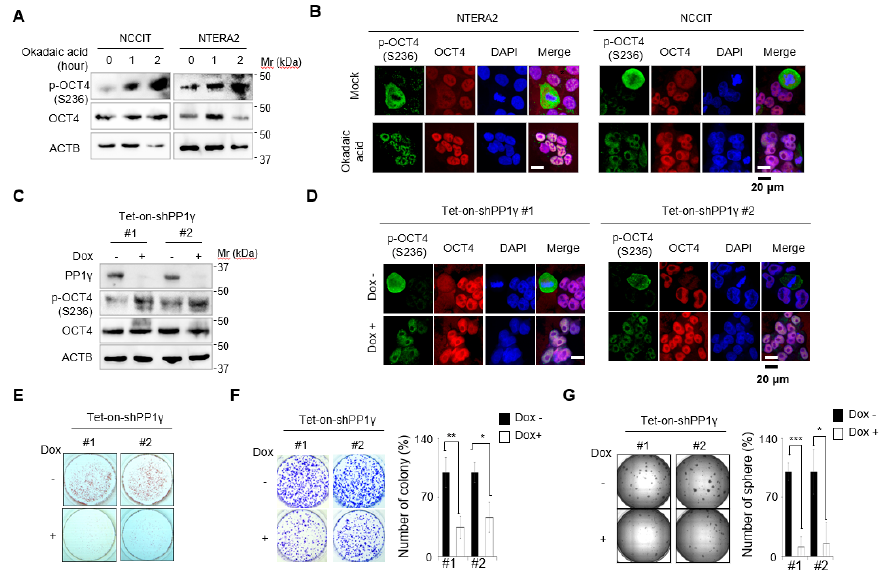
Figure 5. Inhibition of PP1 results in accumulation of p-OCT4(S236) and differentiation of GCTs. ( A ) NCCIT and NTERA-2 cells were treated with okadaic acid (50 nM), an inhibitor of PP1, for the indicated times, and the levels of OCT4 and p-OCT4(S236) were determined by Western blot. ( B ) Cells treated with okadaic acid (50 nM) for 2 h were immunostained with the indicated antibodies and analyzed by confocal microscopy. ( C ) NCCIT cells stably incorporating Tet-on-shPP1 γ #1 and #2 were treated with or without Dox for four days. PP1 γ , OCT4, and p-OCT4 (S236) levels were measured by Western blot. ( D ) NCCIT cells indicated in Figure 5C were immunostained with the indicated antibodies and analyzed by confocal microscopy. ( E , F ) Cells were seeded at a low density with or without Dox treatment. Cells were stained with ( E ) AP or ( F ) crystal violet at seven or 14 days after seeding, respectively. ( G ) Cells were plated for tumor sphere formation with or without Dox treatment. Two weeks after plating, the entire images of spheres in 96-well cell culture plates were obtained using Cytation 3. The relative number of colonies (%) for ( F ) and spheres (%) for ( G ) is indicated as the mean ± standard deviation (N = 3, * p < 0.05, ** p < 0.01, *** p < 0.001 relative to Dox nontreated cells), and representative images from three independent experiments are